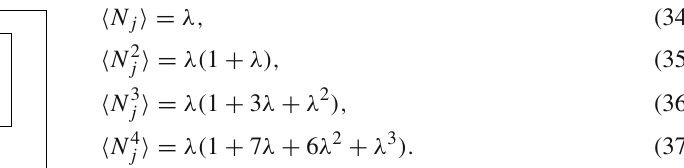
Fig. 1 NA61/SHINE detector acceptance (solid area) with indicated region where particles are identified via their energy loss (magenta stripes) and their time-of-flight (yellow stripes) in p+p interactions at √ s NN = 17 . 3 GeV